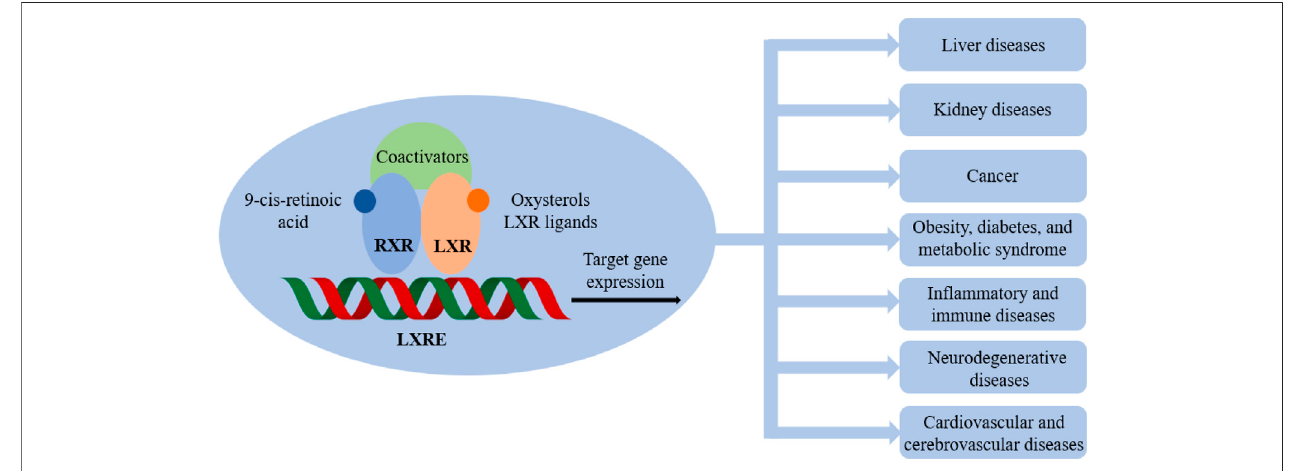
FIGURE 2 | Liver X receptors (LXRs) and related pathological conditions.